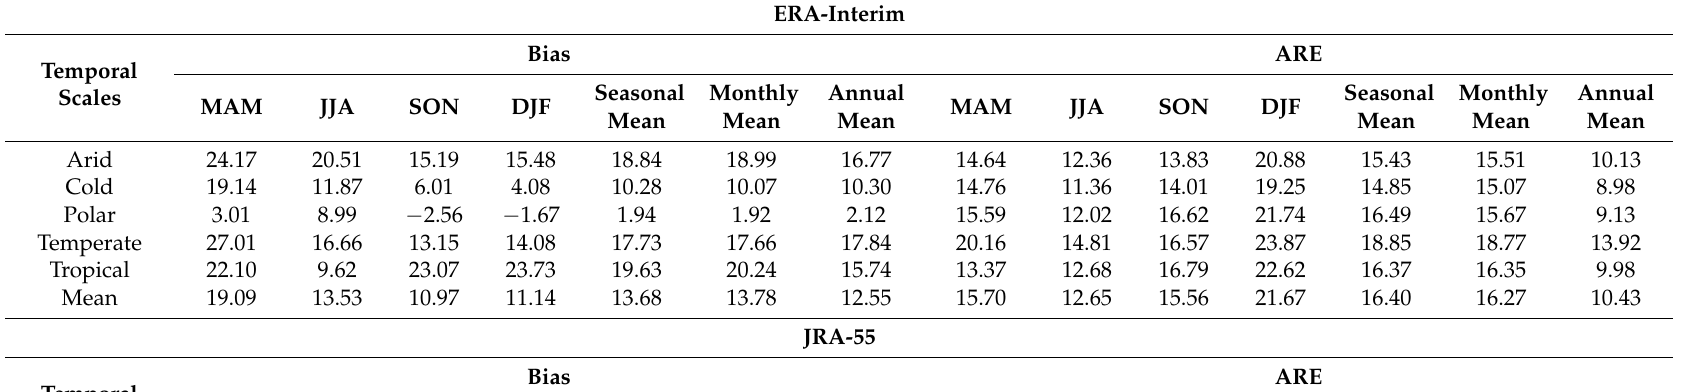
Seasonal Monthly Annual Mean Mean Mean